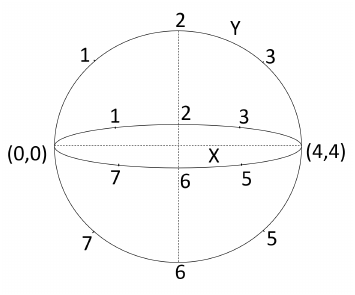
Figure 9. QDRW movement